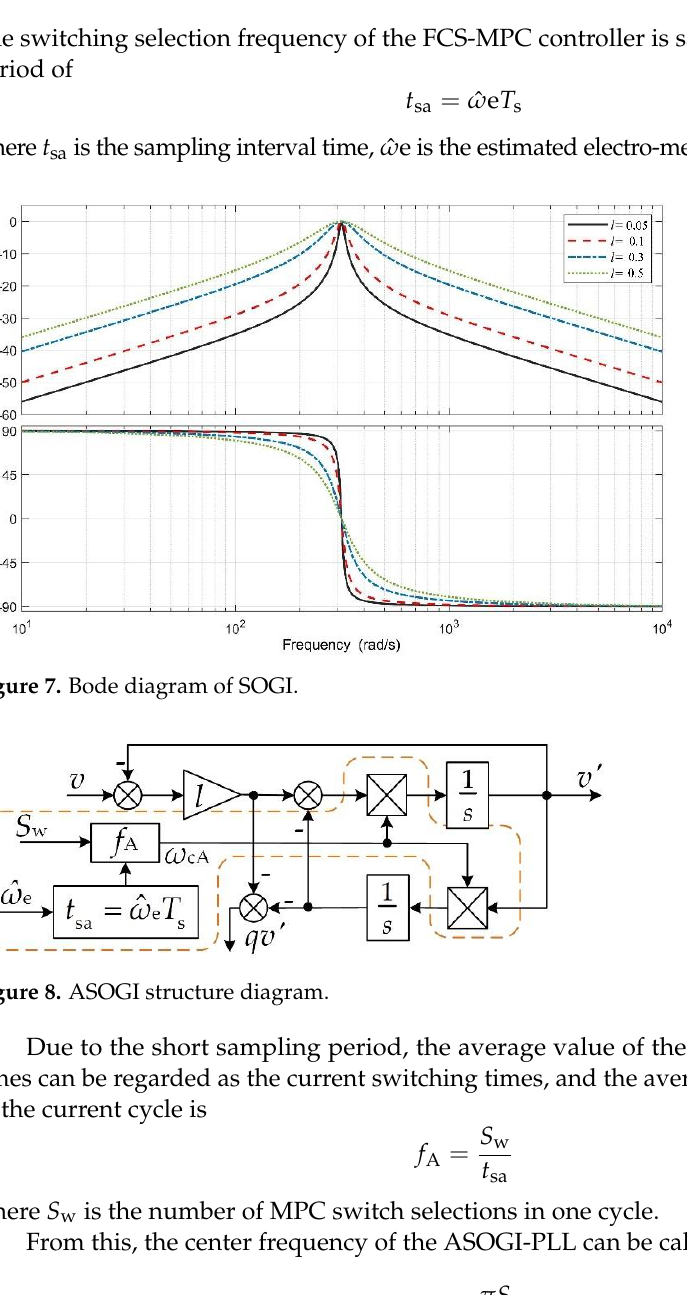
Figure 6. SOGI structure diagram.